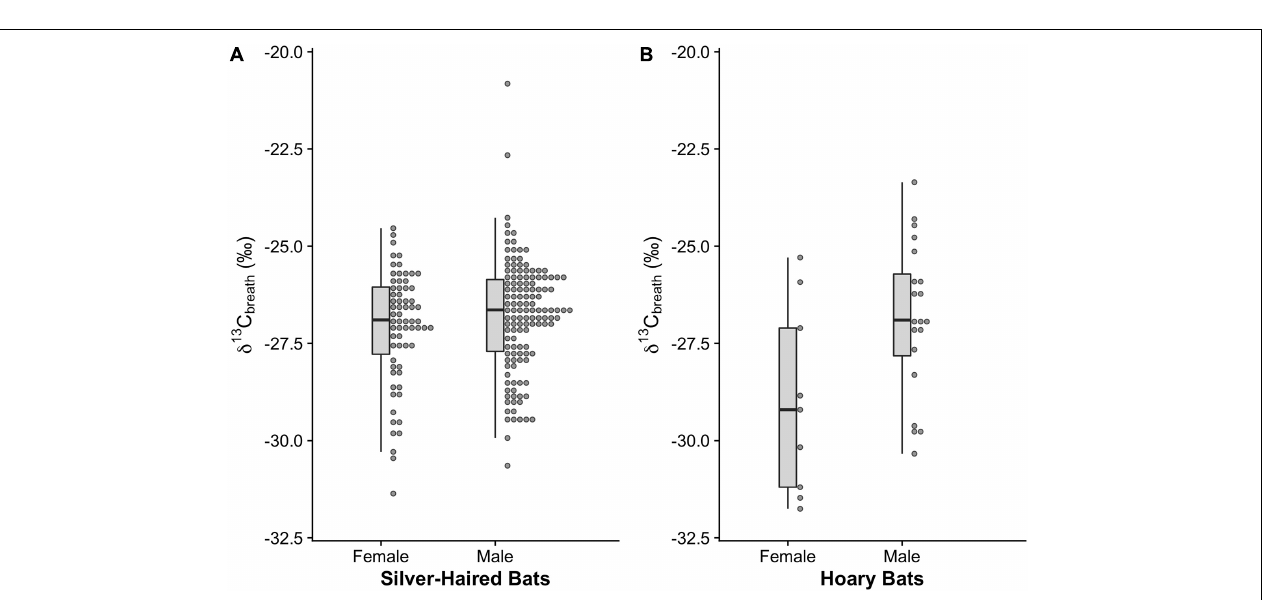
FIGURE 3 | 13 C enrichment in exhaled breath of spring migrating silver-haired and hoary bats. Less negative δ 13 C values are associated with metabolism of exogenous nutrients (foraging) and more negative δ 13 C values are associated with metabolism of endogenous fuel sources (relying on stored fat). Using relative 13 C enrichment as a proxy for foraging proclivity we find that (A) female and male silver-haired bats do not show differences in their proclivity to forage at stopover but that (B) female hoary bats are less likely to forage relative to male hoary bats.